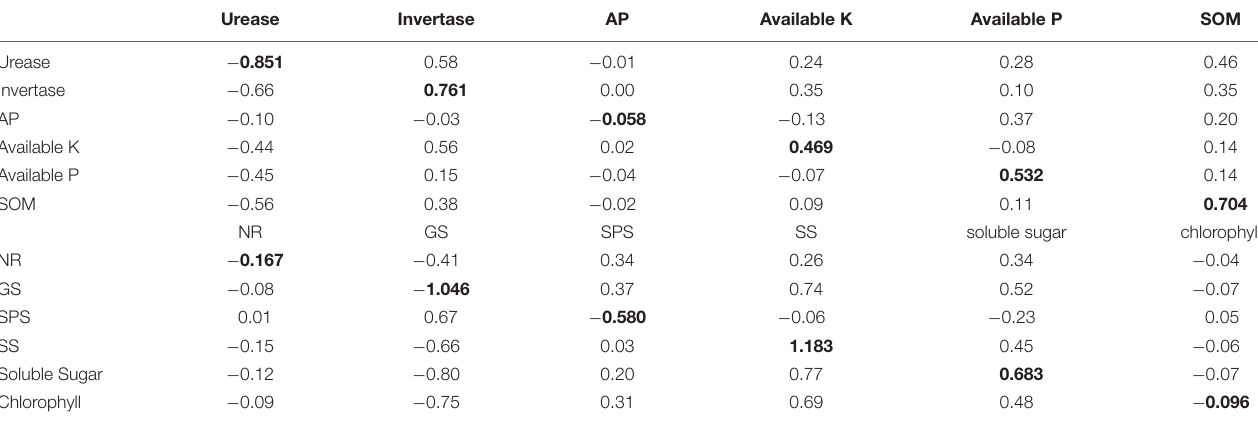
Bold numerals are the direct effect values. AP, acid phosphatase; K, potassium; P, phosphorus; SOM, soil organic matter; NR, nitrate reductase; GS, glutamine synthetase; SS, sucrose synthase; SPS, sucrose phosphate synthase.